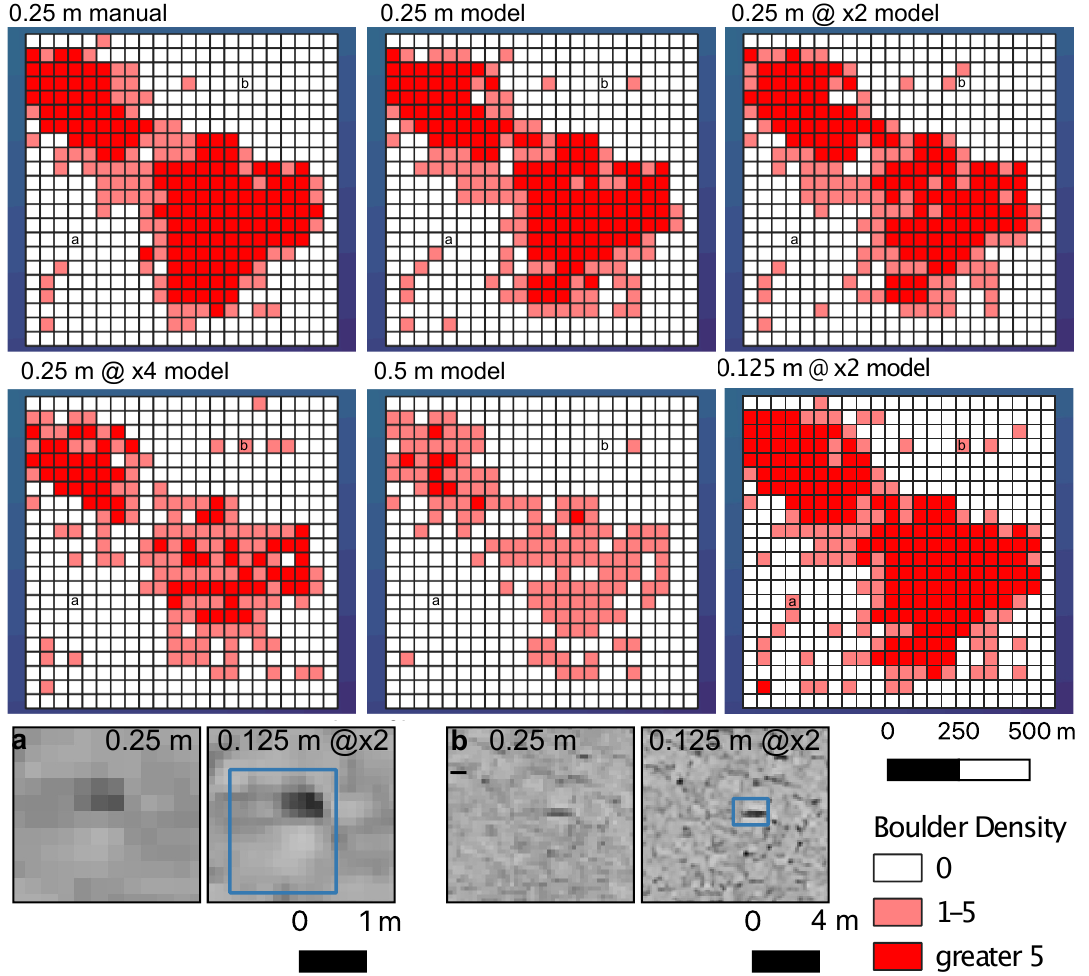
Figure 5. Block densities of the validation area for manual interpretation and the model running on different mosaics. ( a ) hows an example where a grid cell classification changed after correctly identifying a small boulder following upscaling to 0.125 m resolution. ( b ) shows an example where a grid cell classification changed due to mis-interpretation of water column stratification after upscaling to 0.125 m resolution.